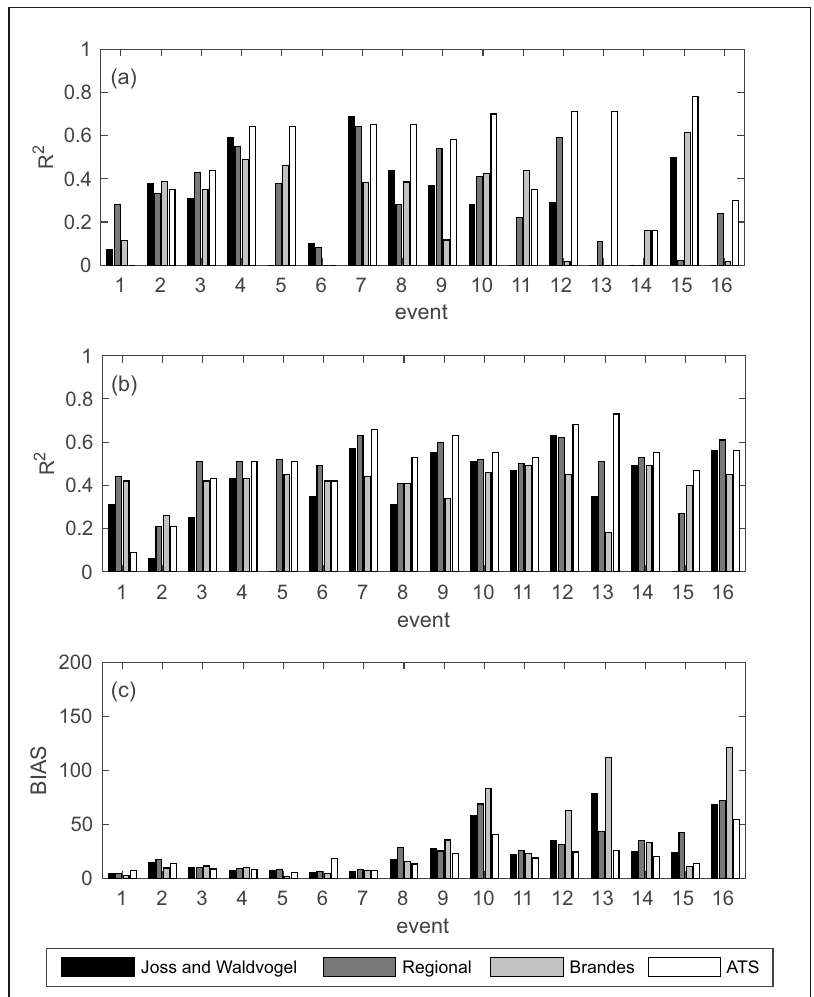
Figure 5. Comparison between the coefficients of determination obtained with the Joss-Waldvogel formula, the regional formula, the methodology proposed in [26] and the ATS technique ( a ) at the event scale and ( b ) at the hourly scale. Correlation coefficient R 2 falling outside the range (0,1) have not been reported. ( c ) reports the comparison between the BIAS obtained with the four above-mentioned methodologies at the event